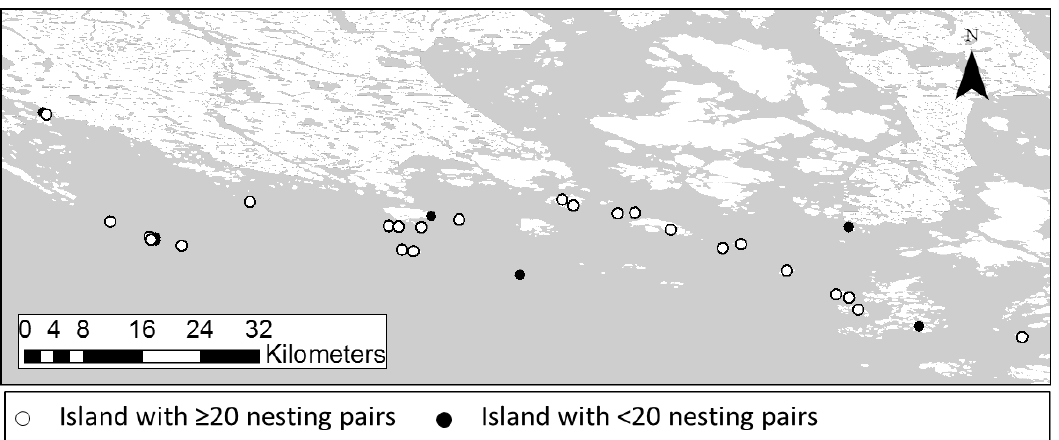
Figure A1.9. Survey zone 9: Chorkbak Inlet, Southern Baffin Island